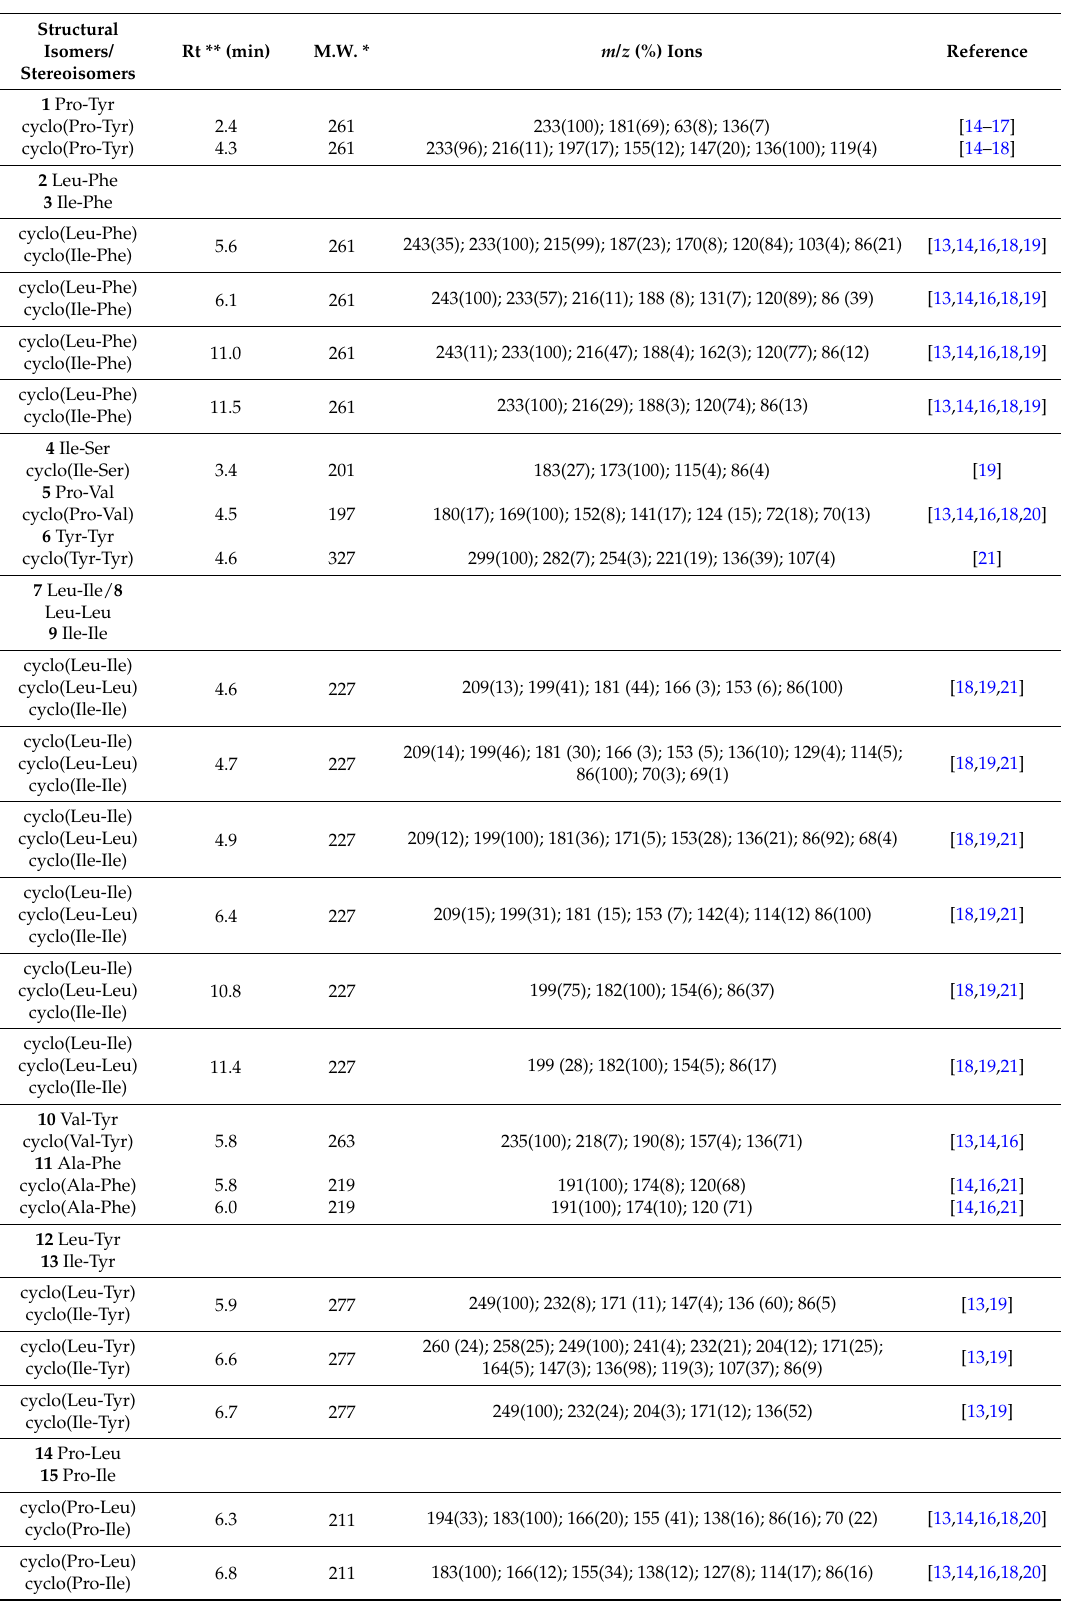
Table 1. Compounds identified by UFLC-ESI-IT in acellular culture supernatant residues from X. fastidiosa 9a5c grown in XFM